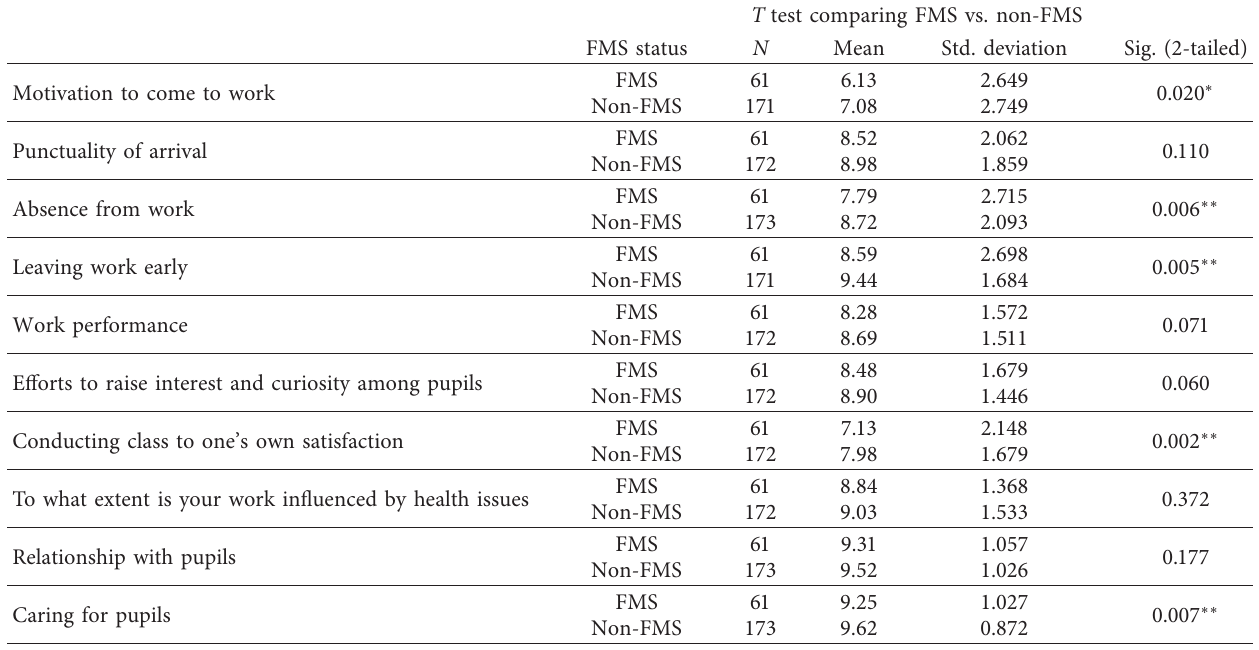
Table 3: Comparison between FMS and non-FMS kindergarten teachers regarding work-related performance ( T test). T test comparing FMS vs. non-FMS